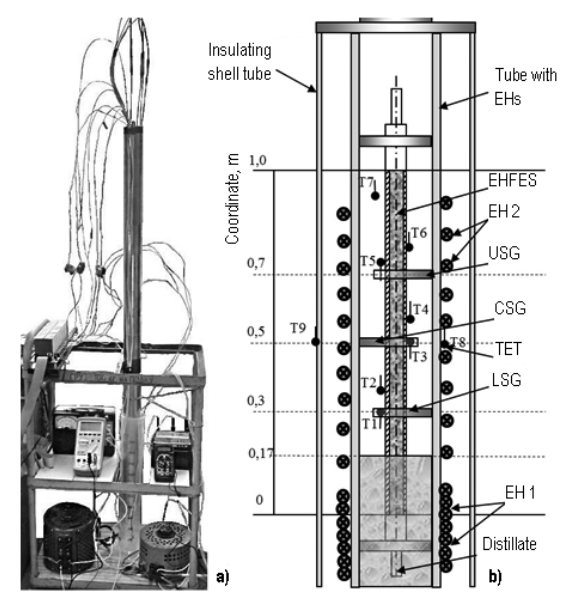
Figure 1. Laboratory facility: a) – overall view; b) – SG and TET arrangement in the